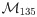
Model M135 predictions and fits to target mRNA data (fold changes) for the Pro→Gln shift.(a) Abundance of GATA factor active forms (nuclear Gln3 and Gat1, and Dal80 and Gzf3 homodimers). In the case of Gln3 and Gat1, the observed decrease is accompanied by an increase in cytosolic concentration (not shown). The decrease of Dal80 is due to protein degradation/dilution as its expression is turned off. (b) Contribution of each GATA factor active form to the fractional occupancy of its target promoters, calculated as described in Section 2.2 of S1 Text. TFs with the greatest relative contribution to the fractional occupancy of a given target promoter at a given time are those that mainly control the expression of the corresponding target gene at that time. (c) Fits of the mRNA abundance of GATA targets. In parts (a) and (c), upper and lower continuous lines denote 90% and 10% quantiles respectively, based on the 500 parameter estimates with the highest posterior probability. In part (c), dashed lines correspond to the mean prediction and square markers denote measurements. In part (b), predictions are based on the maximum a posteriori (MAP) parameter estimate. TF contributions are color-coded according to part (a) (blue denotes the joint regulation by Gln3 and Gat1), and are given in logarithmic (base 10) scale due to their wide dynamic range.